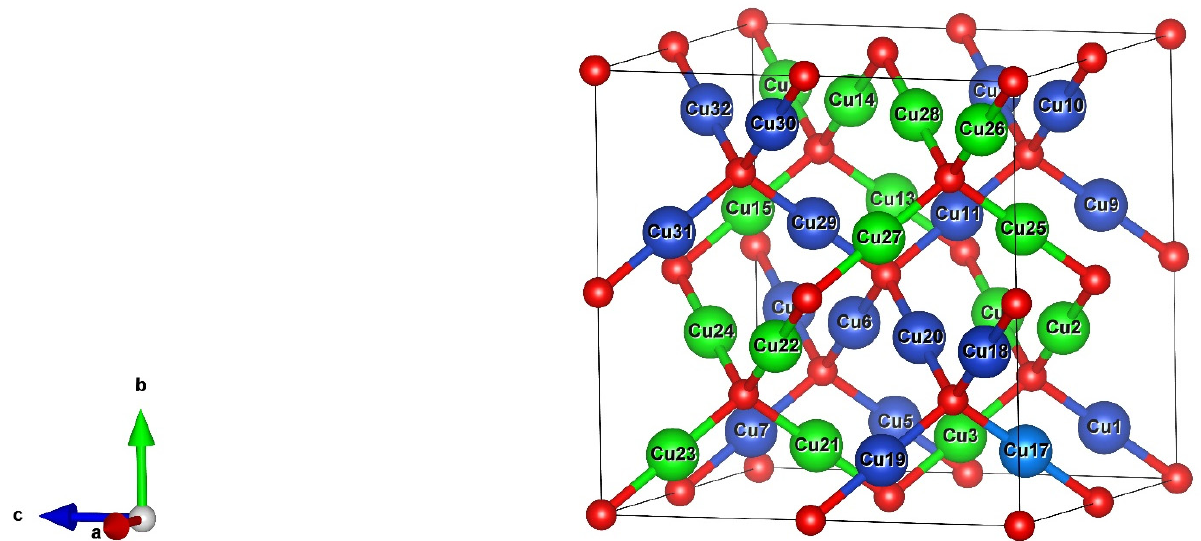
Figure 2. VESTA representation of a Cu 32 O 16 supercell. Oxygen atoms are in red while the Cu atoms of the Table 1. Provides the lattice constant and the crystal structure. A transformation of Cu 2 O from the cuprite to a hexagonal structure occurs at the high pressure of 10 GPa ( a = 4.18 Å). This hexagonal structure changes in the pressure range from 13 to 18 GPa into another hexagonal one, with CdCl 2 type structure. Up to 24 GPa, the highest pressure studied, no decomposition of Cu 2 O into Cu and CuO was observed. Anyway, the only structure here considered is the one stable at atmospheric pressure.